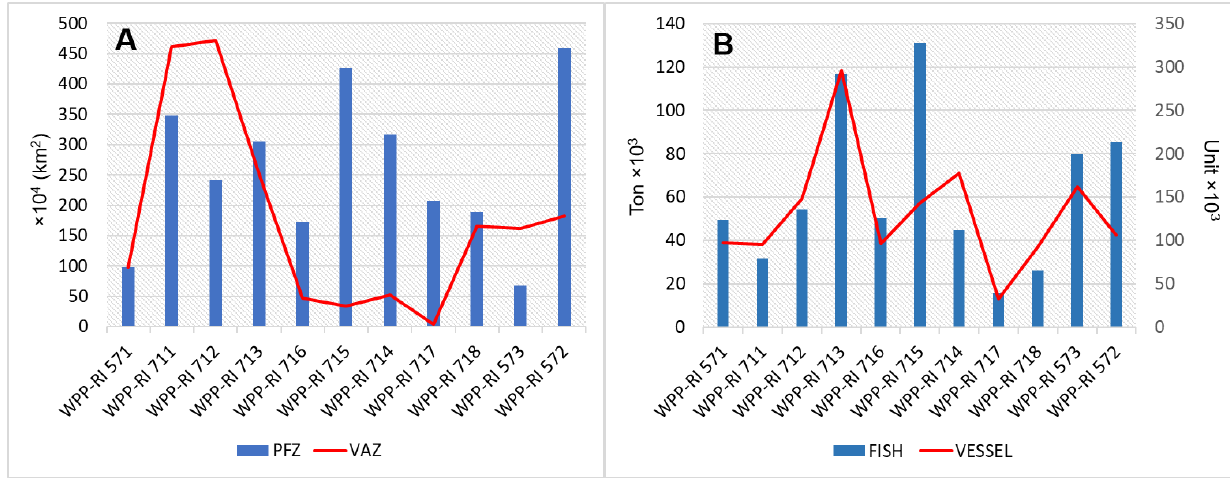
Figure 15. Comparison of the MMAF data and our study results: ( A ) Area of the potential fishing zone (PFZ) and vessel activity zone (VAZ); ( B ) fish production and number of fishing boats based on the data from the Ministry of Marine Affairs and Fisheries.